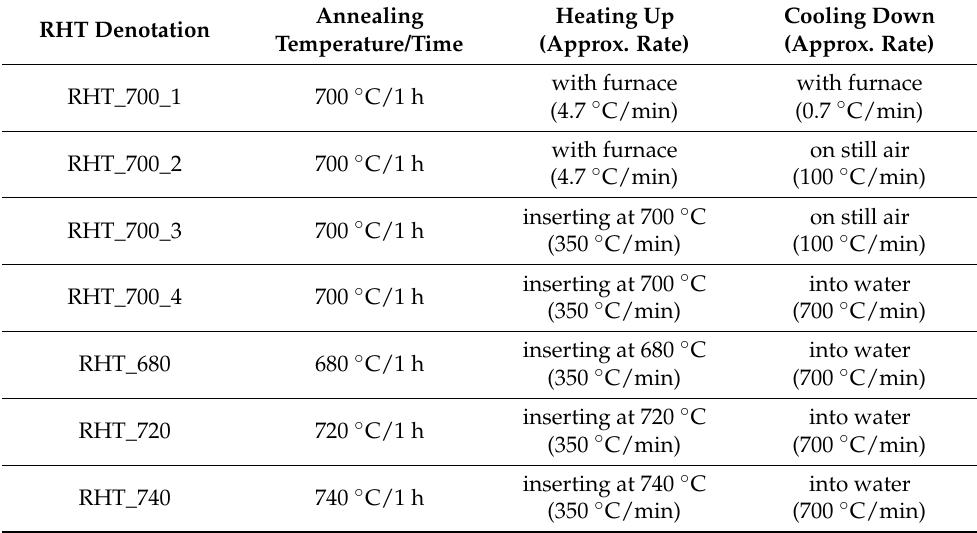
Table 2. Rejuvenation heat treatment (RHT)